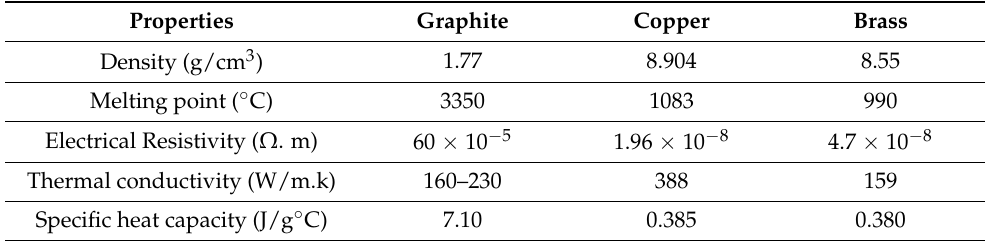
Table 4. Details of electrode materials properties [43–45].